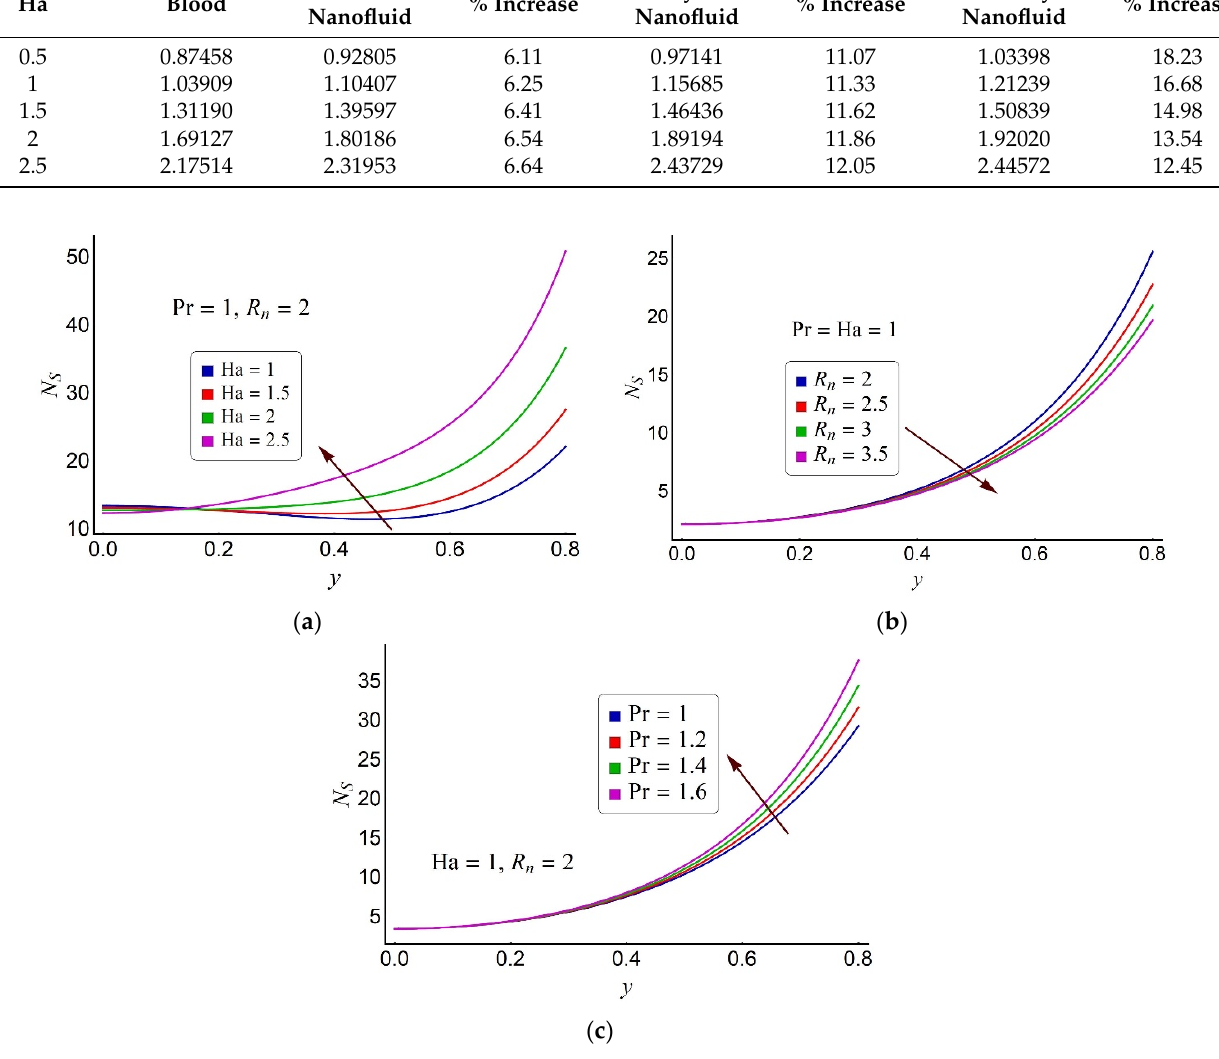
Figure 6. Variations in entropy generation number distribution for different values of ( a ) the Hart- mann number (Ha), ( b ) the thermal radiation number ( R n ), and ( c ) the Prandtl number (Pr). Table 3. The heat transfer rate for blood, mono nanofluid, hybrid nanofluid, and tri-hybrid